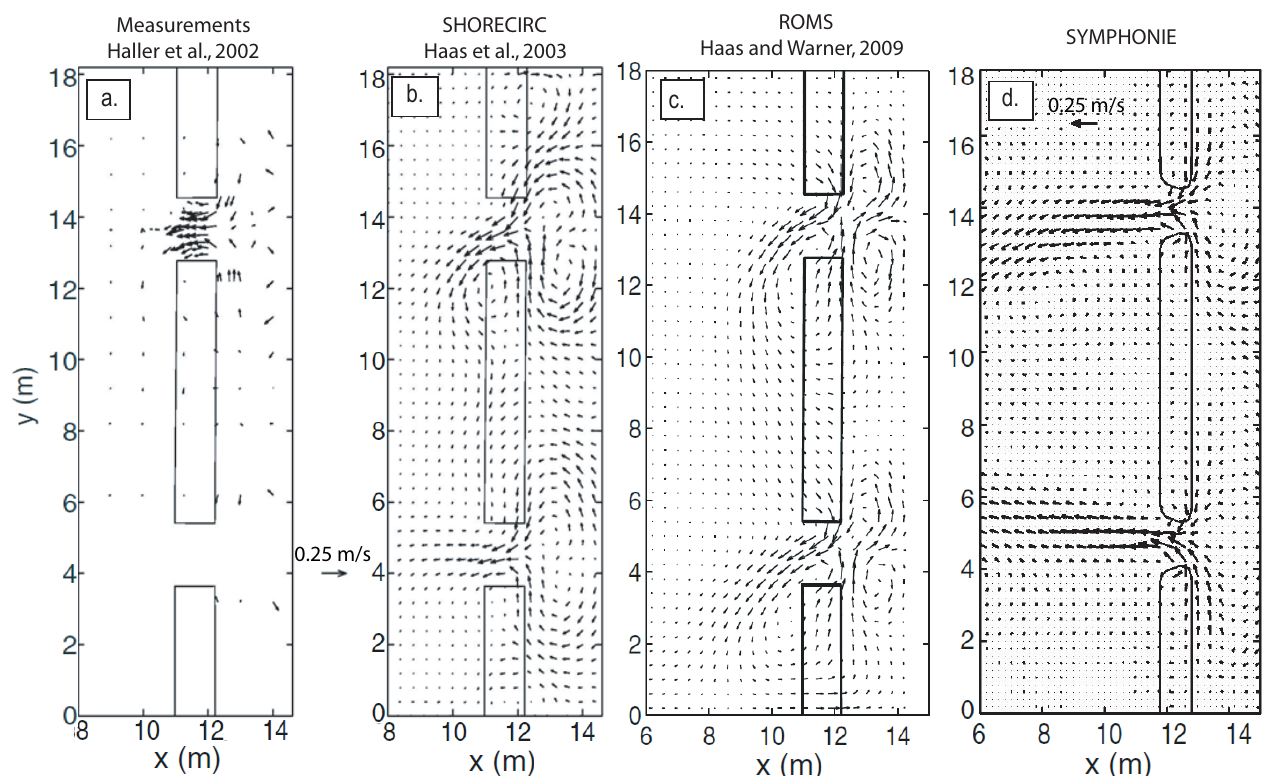
Fig. 6. Comparison of time-averaged depth-integrated current measured by Haller et al. (2002) (a) , with numerical simulations done by SHORECIRC (Haas et al., 2003) (b) , ROMS (Haas and Warner, 2009) (c) and SYMPHONIE (d)